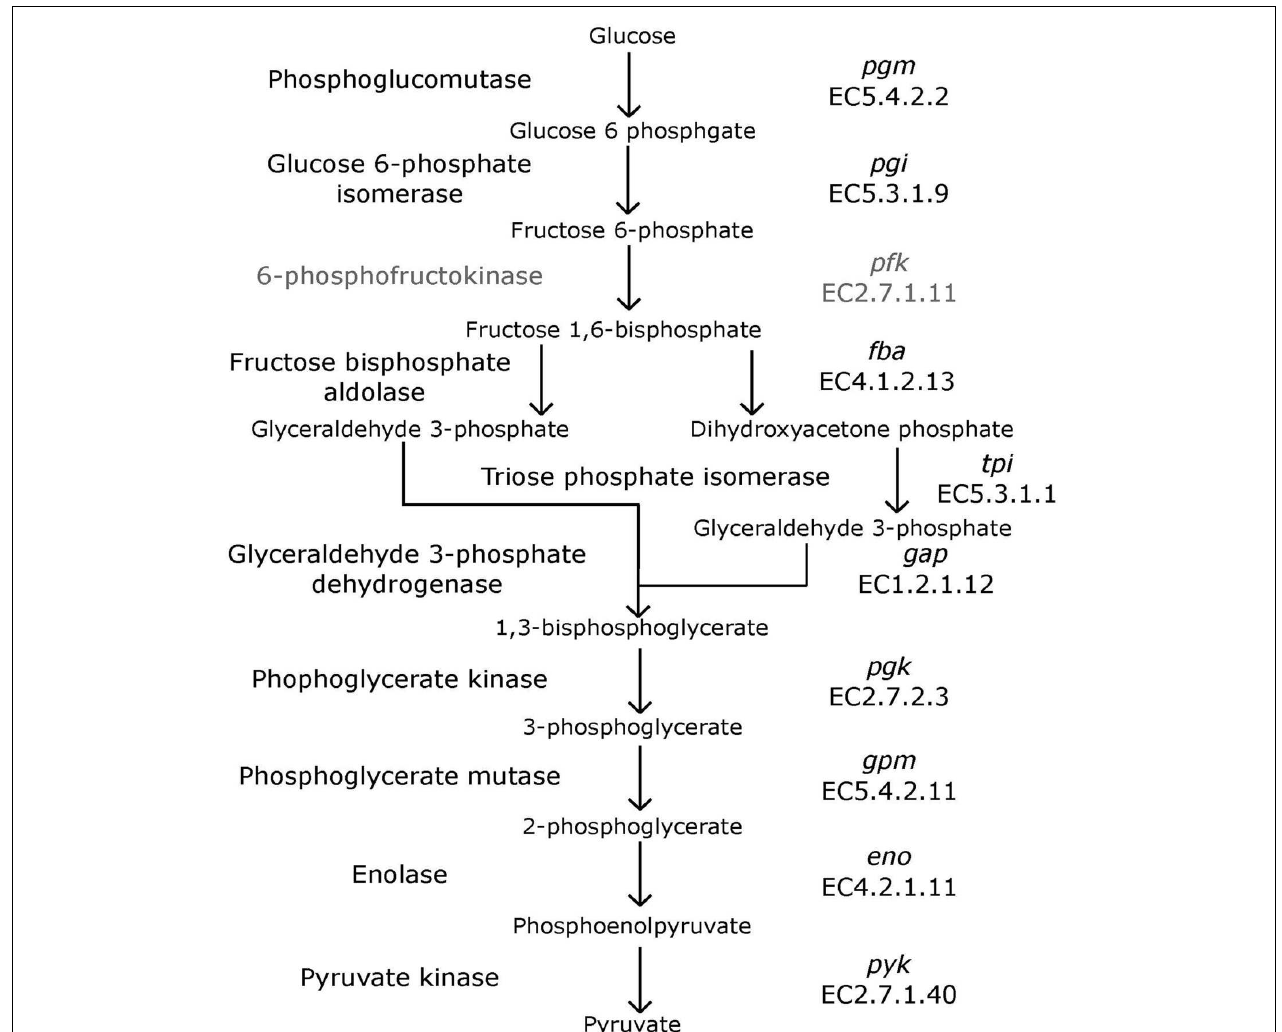
FIGURE 1 | Glycolysis pathway. Traditional biochemical pathway of glycolysis. Enzyme names are listed to left of arrows, and gene names and EC numbers are shown on the right. 6-phosphofructokinase is faded to represent its absence in Bifidobacterium .